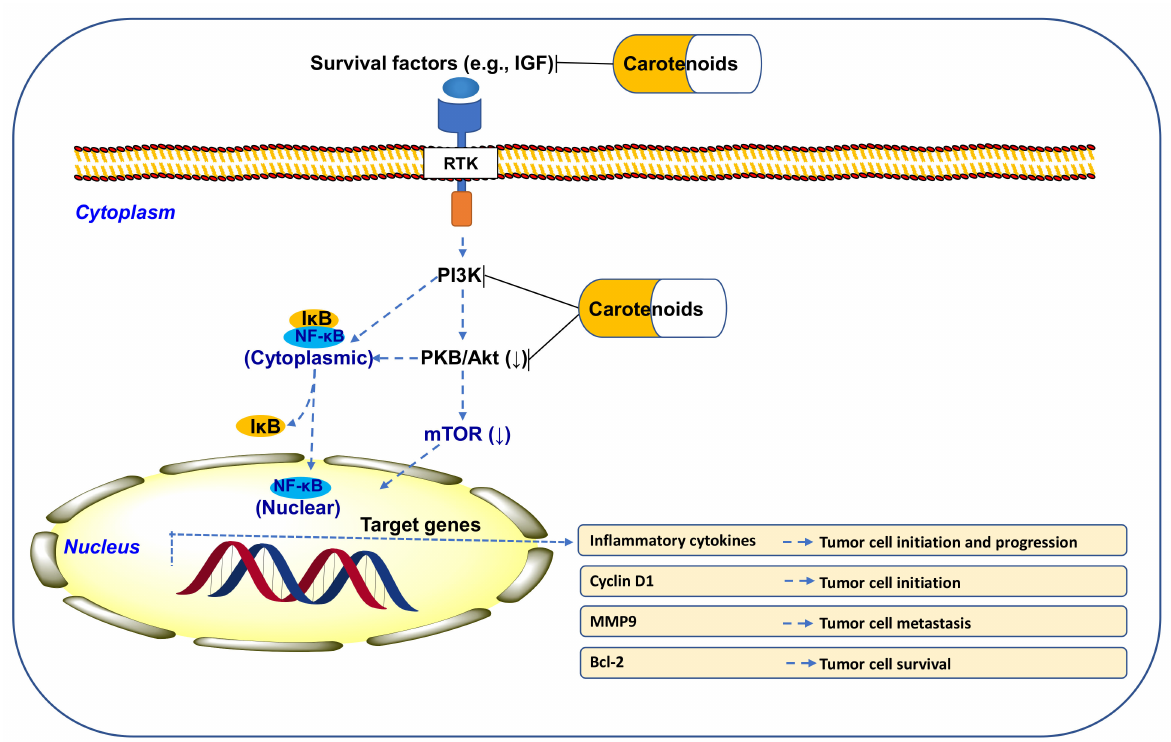
Figure 7. Carotenoids block the phosphoinositide 3-kinase (PI3K)/phosphorylated protein kinase B (PKB or Akt)/mechanistic target of rapamycin (mTOR) signaling pathways, thus reducing tumor cell initiation, progression, and metastasis. Abbreviations: Bcl-2: B-cell lymphoma 2: IGF: Insulin-like growth factor: MMP9: Matrix Metallopeptidase